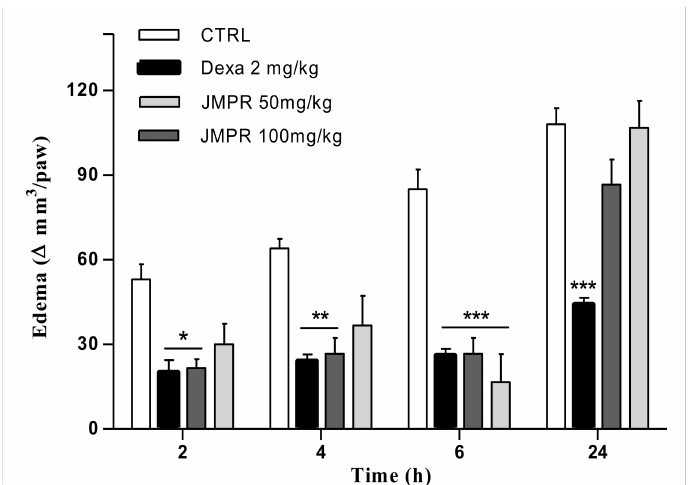
Figure 5. Influence of JMPR-01 (50 and 100 mg/kg) in the CFA-induced paw edema. Paw edema was measured 2, 4, 6 and 24 h after CFA, represented as paw volume variation. Data are expressed as means ± SEMs; n = 6 mice per group. Two-way ANOVA followed by the Bonferroni’s test. * ( p < 0.05), ** ( p < 0.01) and *** ( p < 0.001) significantly different from the control